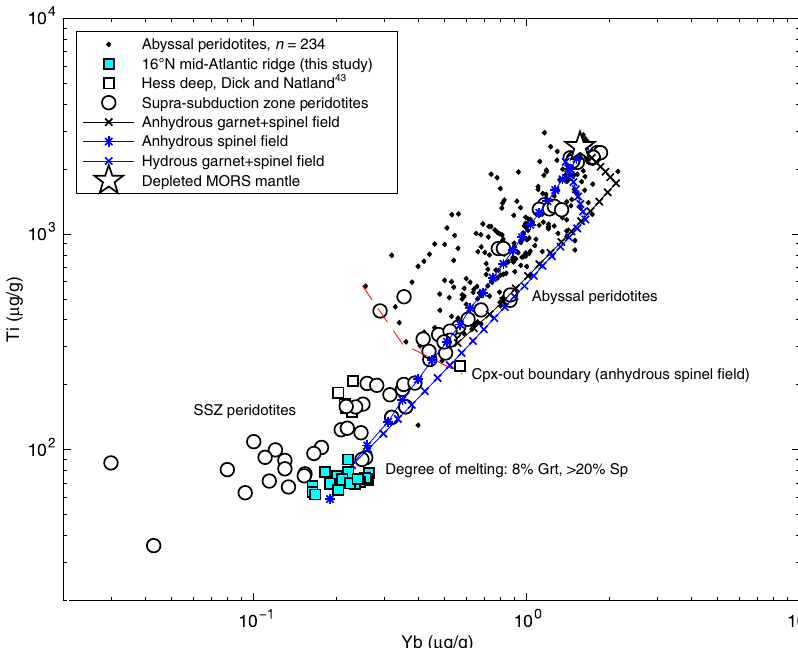
Fig. 4 Fractional melting model of incompatible elements titanium and ytterbium in clinopyroxene. Anhydrous melting alone cannot replicate the ultra- refractory Cpx compositions before Cpx is exhausted, whether one considers spinel fi eld or garnet followed by spinel fi eld (black ticked line) melting. However, changes in melting modes and partition coef fi cients in a hydrous melting environment permit extreme depletions in Ti, matching observations (blue lines). Cyan squares represent each individual measurement from 16°N Cpx (Supplementary Data 2). Red dashed line is approximate spinel- fi eld Cpx-out boundary based on modeled anhydrous melting of DMM spinel bearing peridotite. Model details, including melting modes and partition coef fi cients, can be found in the Methods section and Supplementary Data 5. SSZ peridotites are thought to have undergone extreme degrees of melting in a mantle wedge setting, often resulting in the exhaustion of Cpx; SSZ Cpx Ti and Yb abundances are very similar to those observed in 16°N Cpx. Abyssal peridotite data from the literature as compiled by Warren 42 . SSZ peridotite data from the literature 36 – 39